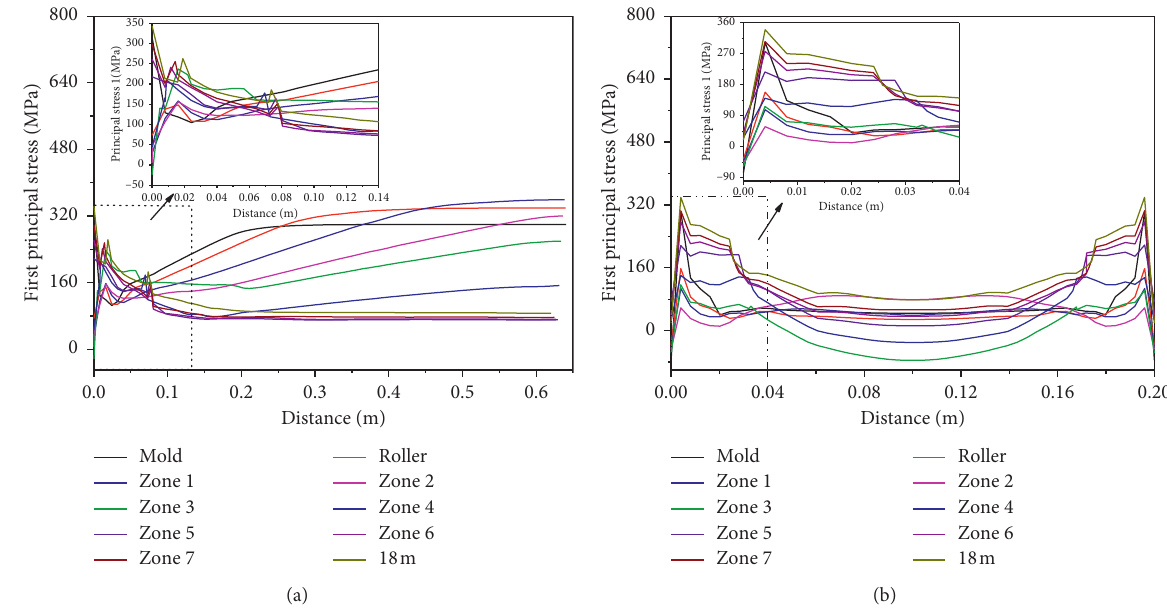
Figure 10: First principal stress curves of the casting slab. (a) 4mm below the wide surface. (b) 6 mm below the narrow surface.